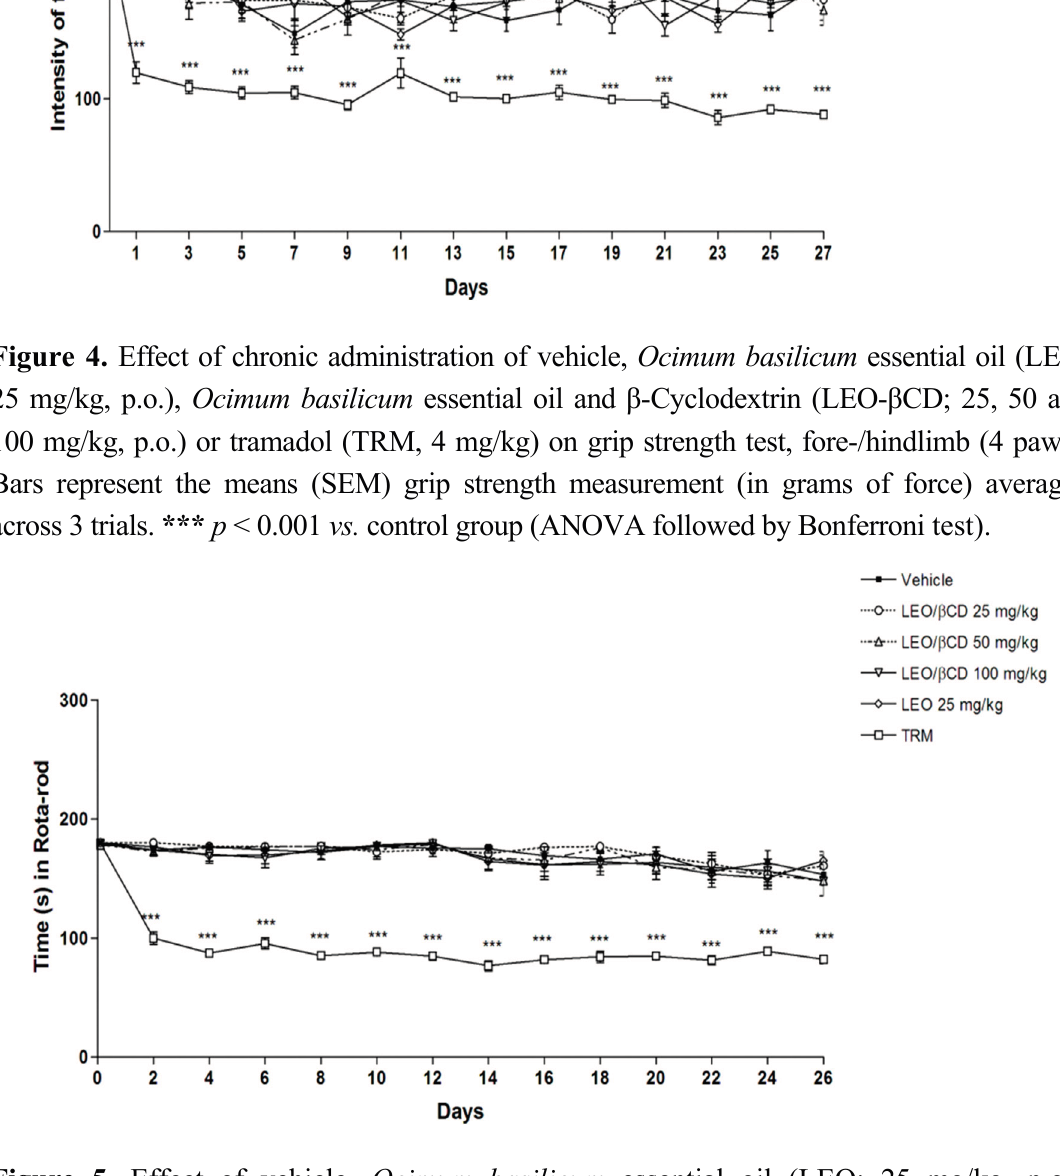
Figure 5. Effect of vehicle, Ocimum basilicum essential oil (LEO; 25 mg/kg, p.o.), Ocimum basilicum essential oil and β -Cyclodextrin (LEO- β CD; 25, 50 and 100 mg/kg, p.o.) or tramadol (TRM, 4 mg/kg) on the rota-rod test in mice. Values are the mean ± SEM ( n = 8, per group). *** p < 0.001 vs. control group (ANOVA followed by Bonferroni